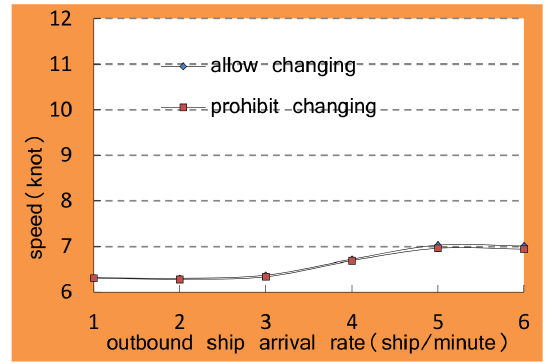
Figure 20. Average speed of waterway system and ship arrival rate as a function (inbound ship arrival rate = 1)